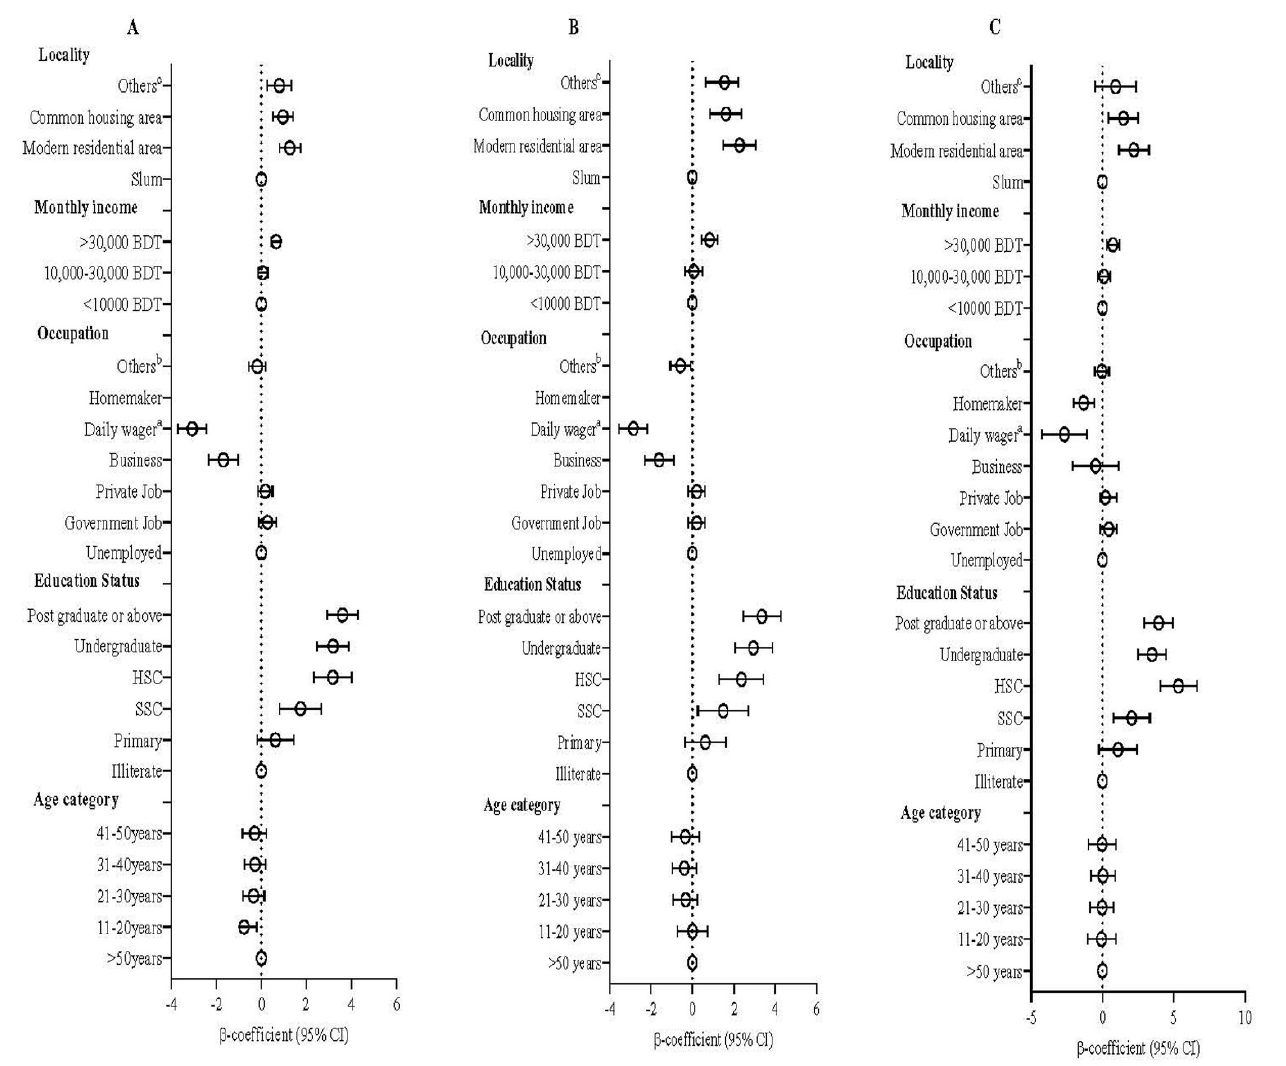
Figure 1. Association of socio-demographic factors and predicting HSB during the pandemic in the whole study population ( A ), Male ( B ), and Female ( C ). The multivariate regression model was used to estimate the p -value. BDT = Bangladeshi Taka (Equivalent to 0.012 USD), a Rickshaw puller, Day laborer, etc.; b House tutor, part-time, etc.; c Village, hostel, dormitory, etc.